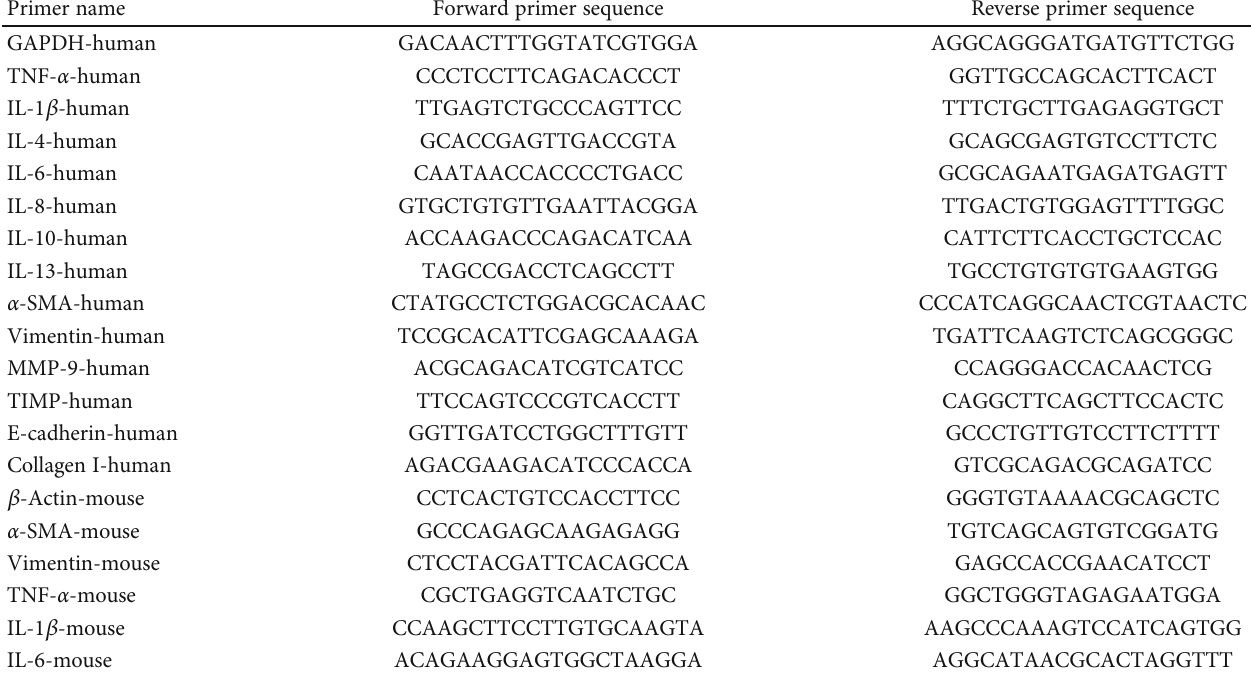
Table 1: The primer sequence for